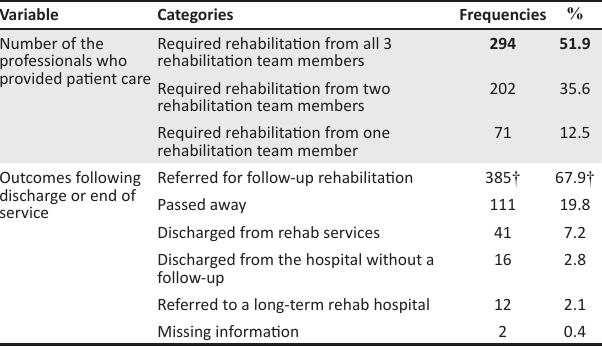
TABLE 3: Determining the care pathway and participant outcomes. Variable